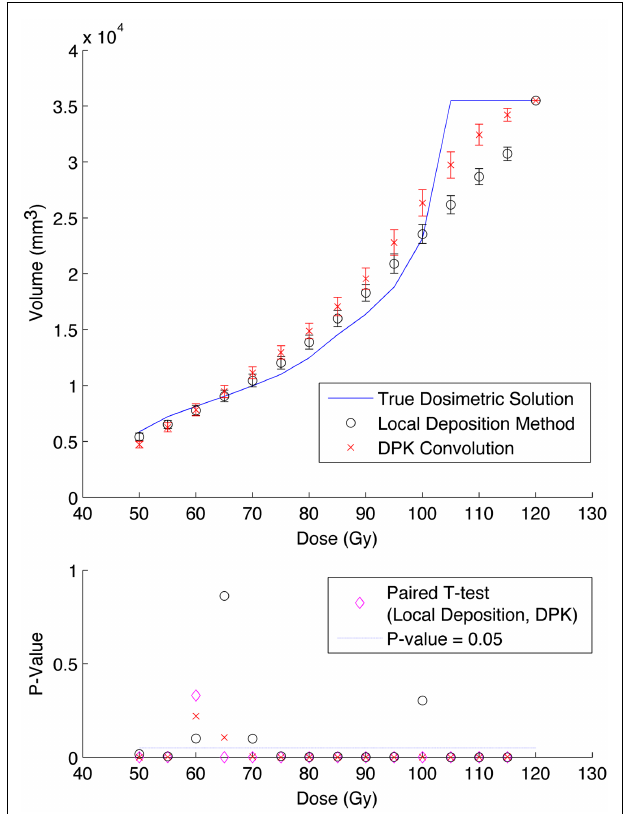
FIGURE 8 |Top: IDVH of NEMA phantom 37mm hot-sphere comparing DPK convolution and the local deposition method, as determined from 6, 40min scans according to recon 3 inTable 1 . Reconstruction was performed using 2mm isotropic voxels with 1 iteration, 21 subsets, and TOF + RR. Both experimental IDVH are compared to the true dosimetric solution IDVH. Bottom: error analysis.